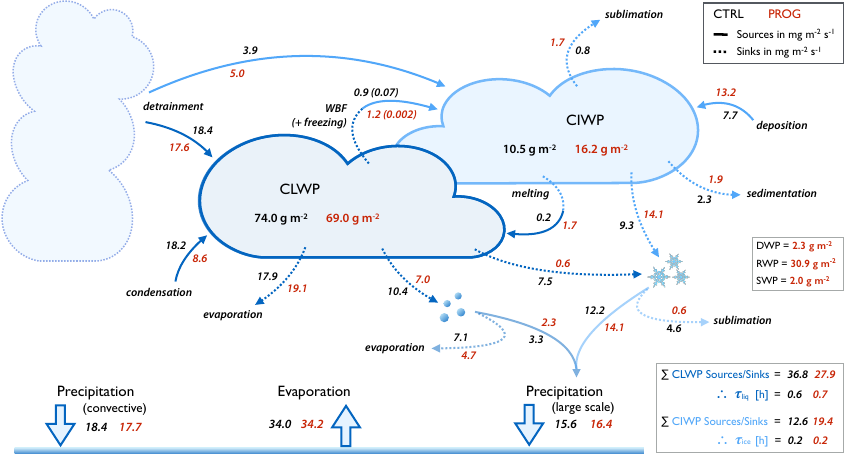
Figure 13. Illustration of the hydrological cycle with all relevant global annual mean (vertically integrated) conversion rates and the cloud lifetimes of CTRL (black) and PROG (red numbers) for the year